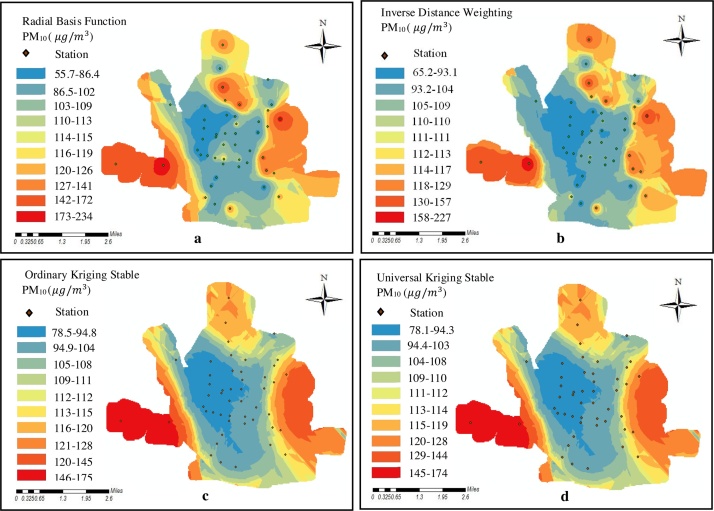
(a) Map of PM10 mean concentrations during 9-month study period estimated by RBF, (b) Map of PM10 concentrations estimated by IDW, (c) Map of PM10 concentrations estimated by OK, and (d) Map of PM10 concentrations estimated by UK.